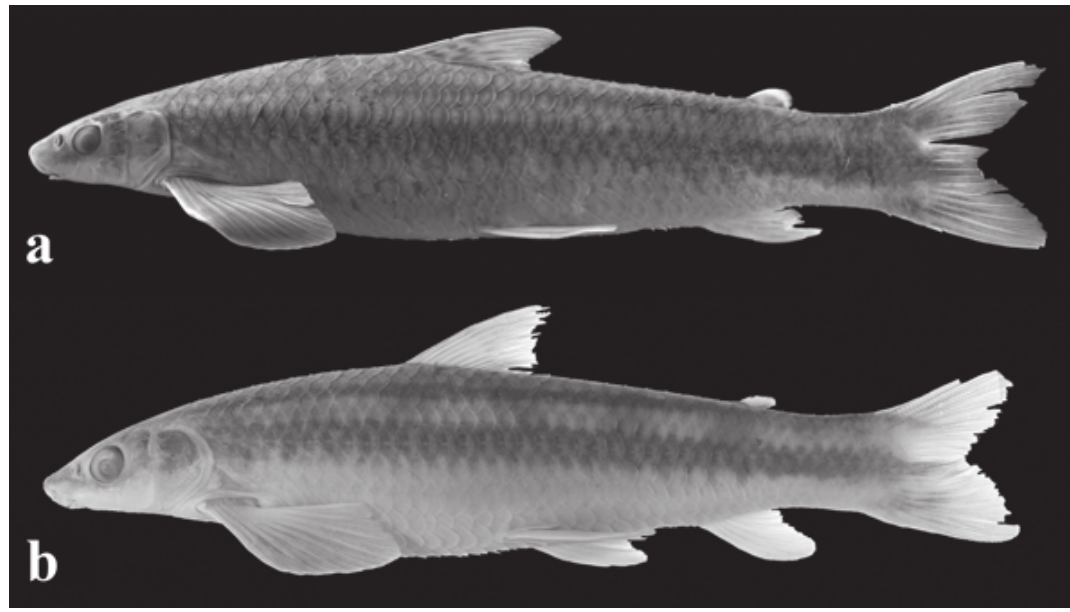
Fig. 1. Parodon orinocensis : ( a ) MBUCV-V 29170, holotype, 131.9 mm SL, Raudal Dimoshi (photo by Carlos do Nascimiento and Nadia Milani); ( b ) AMNH 233108, 99.4 mm SL, Raudal del Danto (photo by Sandra